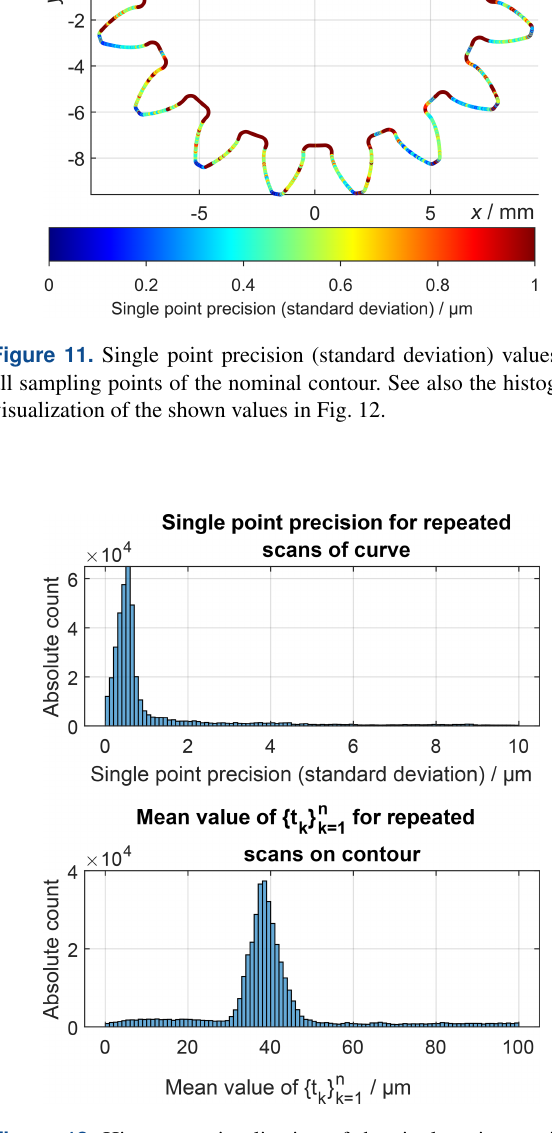
Figure 12. Histogram visualization of the single point precision values (standard deviation) and the mean values of { t k } n sampling points of the nominal gear profile. See also Figs. 11 and 13 for false colour plots.